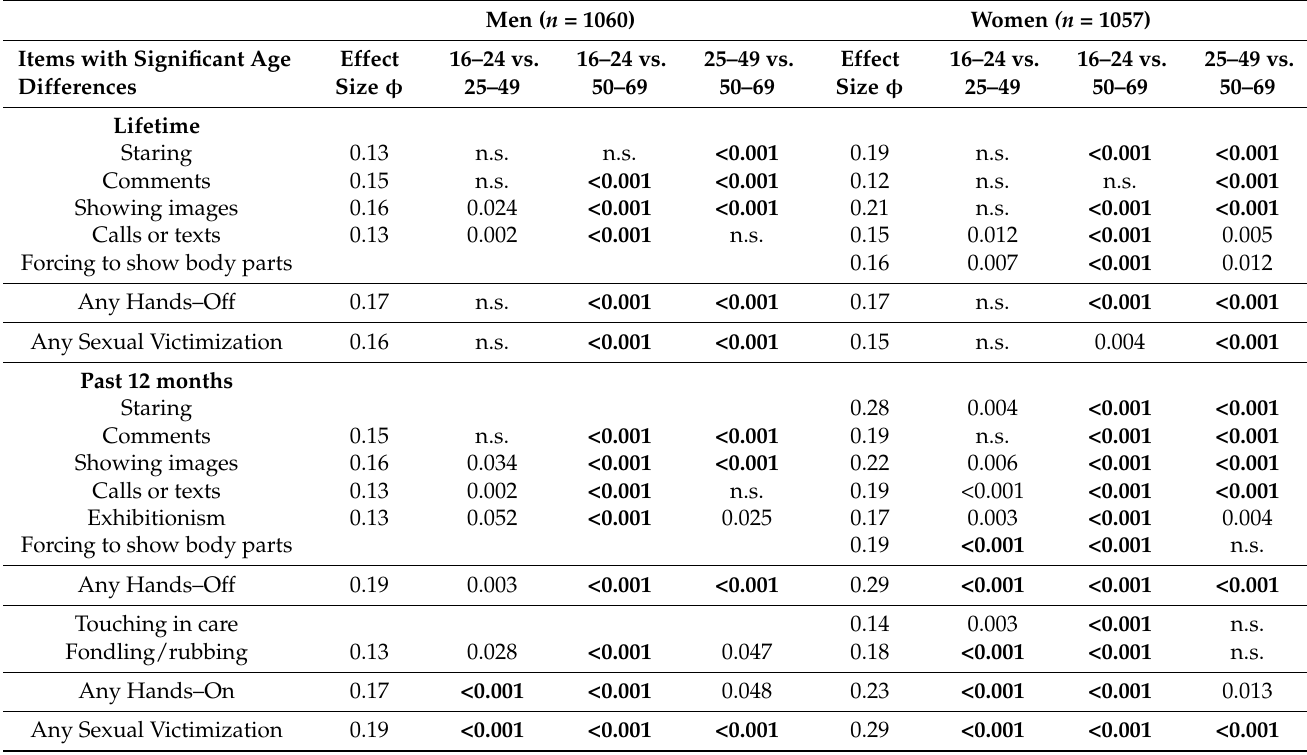
Table 5. Significant differences in the prevalence of forms of sexual victimization between age groups,